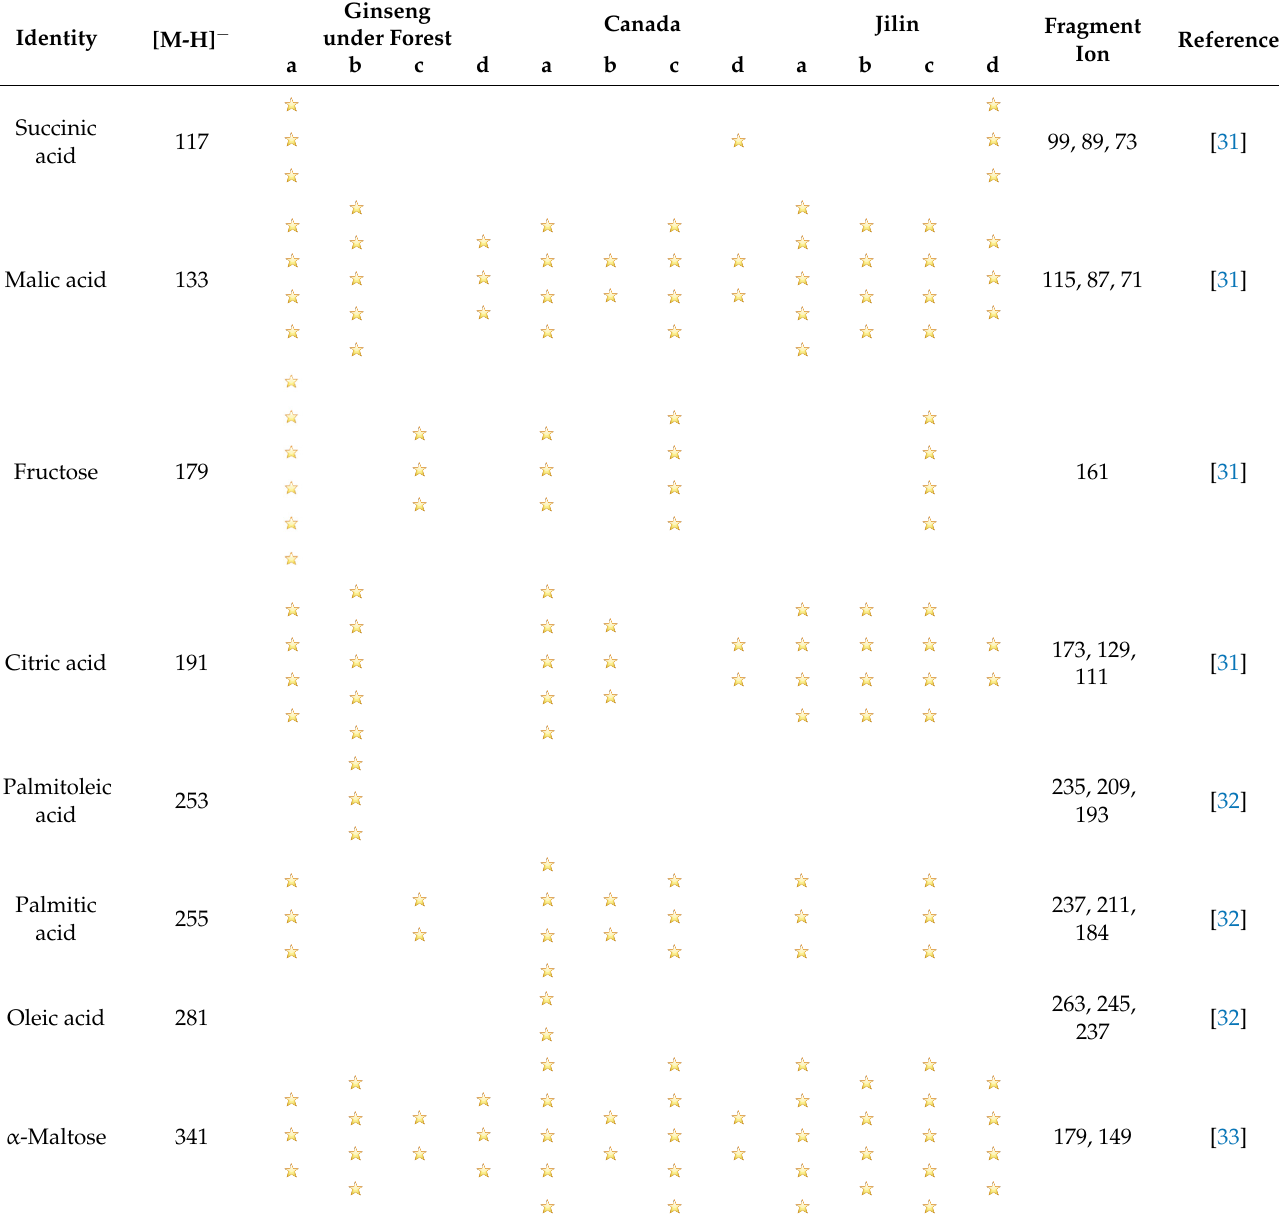
Table 1. Distribution of active metabolite components in the ginseng and Panax quinquefolius samples.